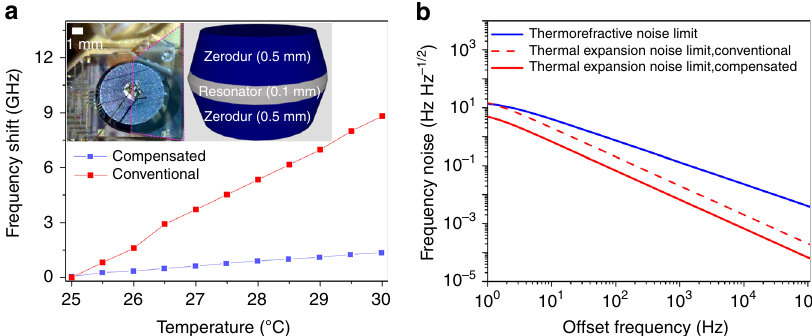
Fig. 1 Thermal-compensation MgF 2 resonator. a Measurement of the frequency shifts for the conventional MgF 2 WGM resonator ( red ) and thermal- compensation WGM resonator ( blue ), respectively. Inset : The MgF 2 resonator (radius: 3.45 mm and thickness: 0.1 mm) sandwiched by Zerodur layers (thickness: 0.5 mm each) in the packaged unit. The MgF 2 resonator ( middle ) is glued in between two Zerodur components ( top and bottom ). The thickness of Zerodur layers is determined by the thermo-mechanical properties of the resonator. b Thermorefractive noise limit ( blue ) and thermal expansion noise limit ( red ) of the WGM resonator. The simulations show that the thermal expansion noise of the compensated resonator ( solid red line ) is lower than the thermorefractive noise near the carrier frequency while the conventional one ( dashed red line ) is similar. Therefore, the fundamental thermorefractive noise fl uctuation can be clearly reached with the compensated resonator in this